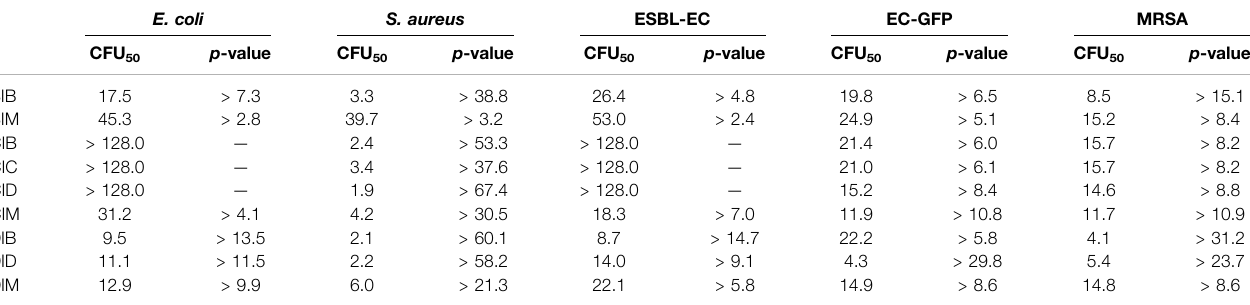
TABLE 3 | CFU 50 (µM) and p -value of R 1 IR 2 and R 1 SR 2 toward E. coli , S. aureus , ESBL-EC, EC-GFP, and MRSA bacteria (CFU 50(R1SR2) > 128.0